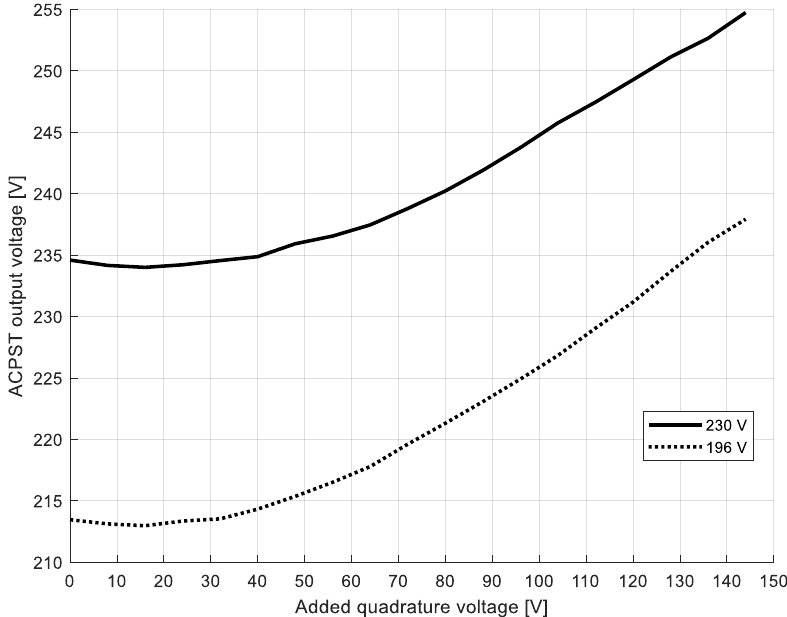
Figure 11. ACPST output voltage versus added quadrature voltage for two cases of longitudinal voltages (230 V — continuous line, 196 V — dotted line).